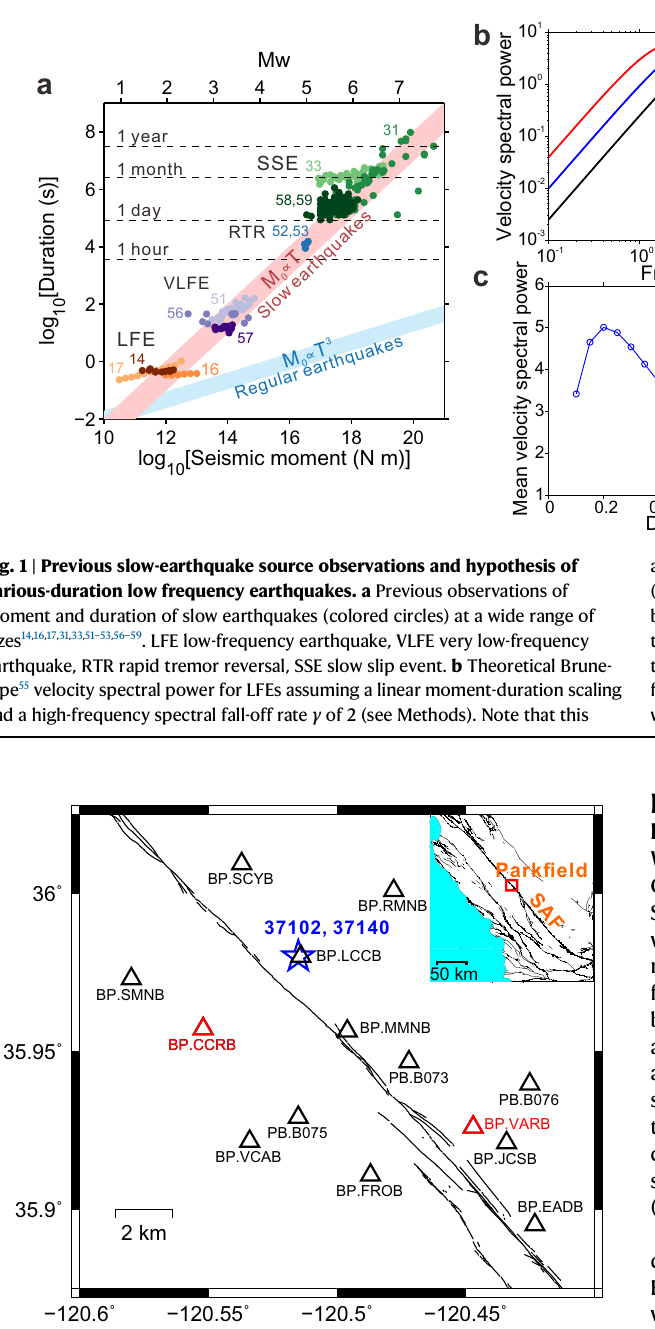
Fig.2|Studyareaandlocationsofseismicstationsandtemplates. Mapshowing locations of the template events for two families (overlapping blue stars) and 14 seismic stations (triangles) in the Park fi eld area. Red triangles denote two inde- pendent stations that are not used in matched- fi lter detection but are reserved for validations. Thin black lines denote the San Andreas Fault Zone (SAF), and the inset